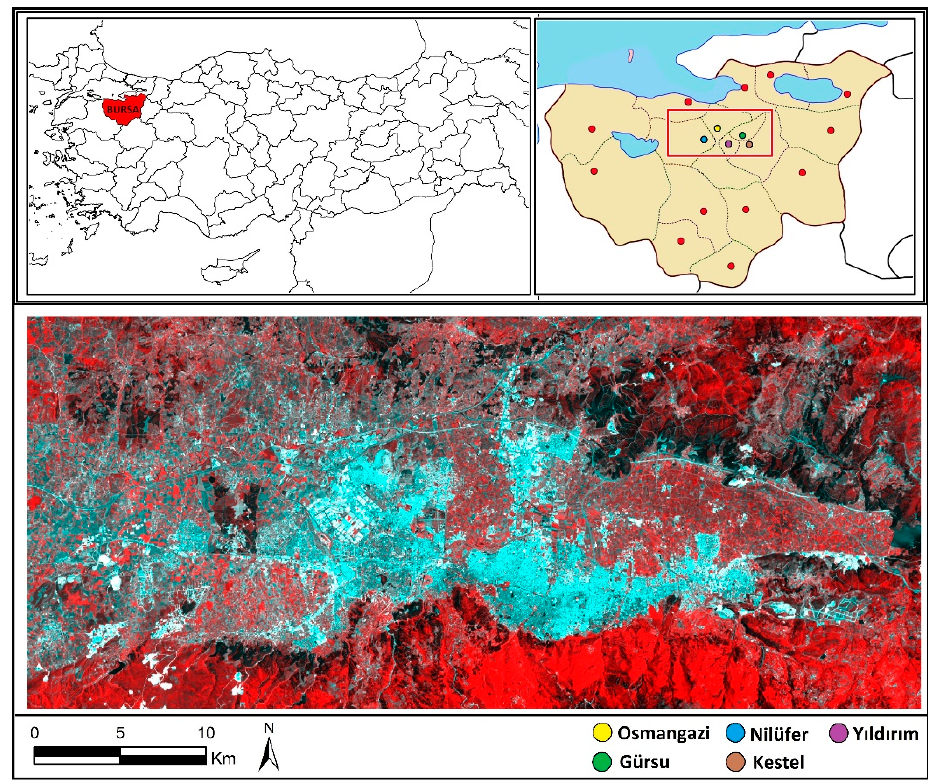
Figure 2. The color infrared Landsat 8 OLI imagery (2020) of the study area and its location in Turkey and Bursa.